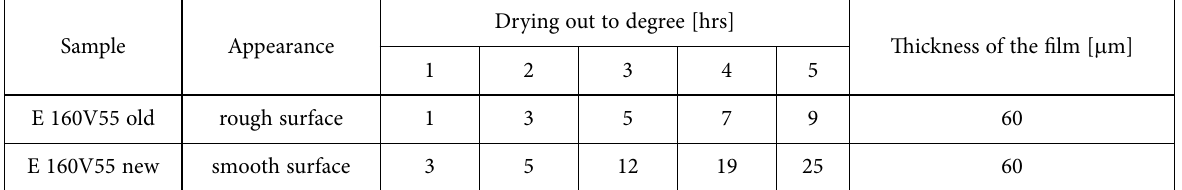
Table 2. The appearance of paints and the drying speeds of paint films